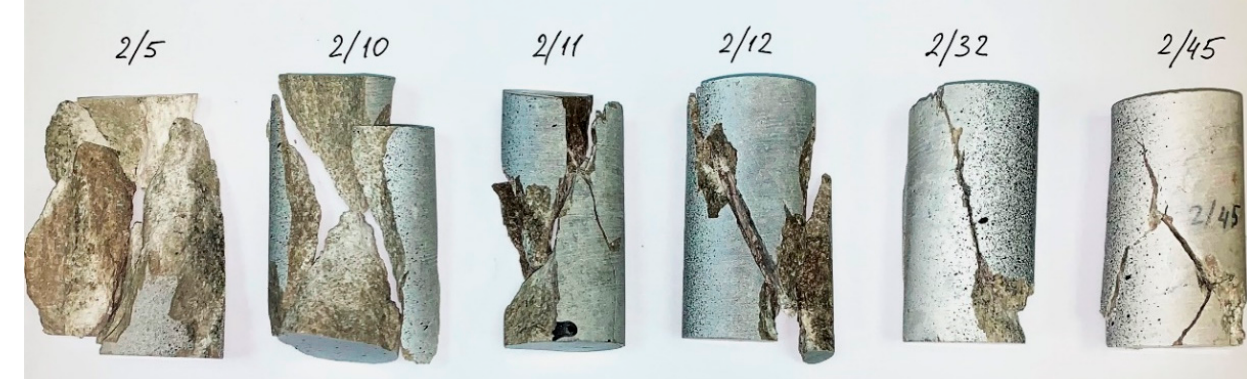
Figure 9. The different modes of failures of rock samples during quasi-static loading: Y-shaped (2/5), double shear (2/10), axial splitting (2/11), shearing along a single plain (2/12, 2/32, 2/45).